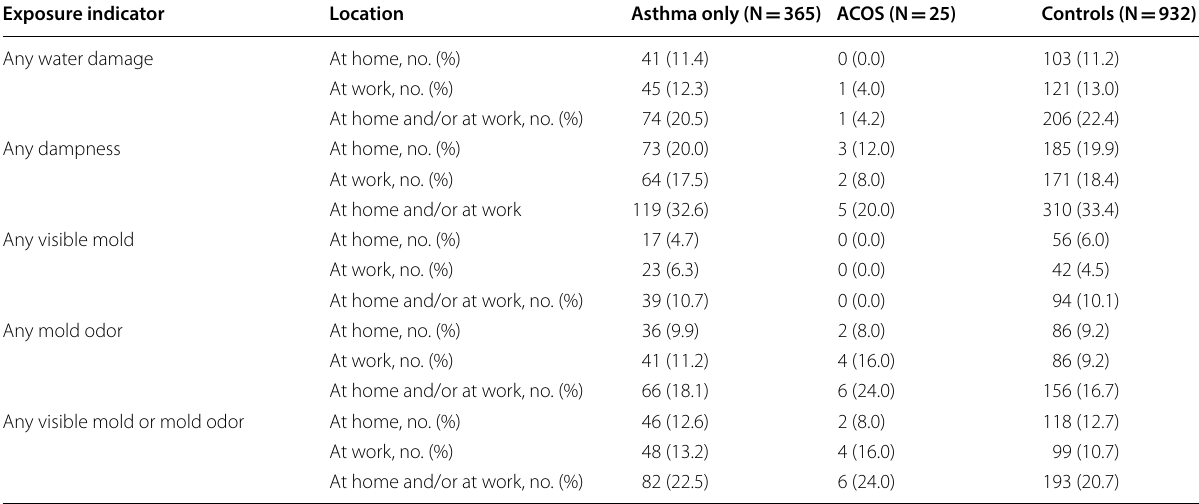
ACOS Asthma-COPD Overlap Syndrome